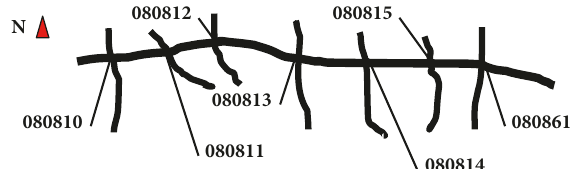
Figure 4: Diagram of the road experimental area.